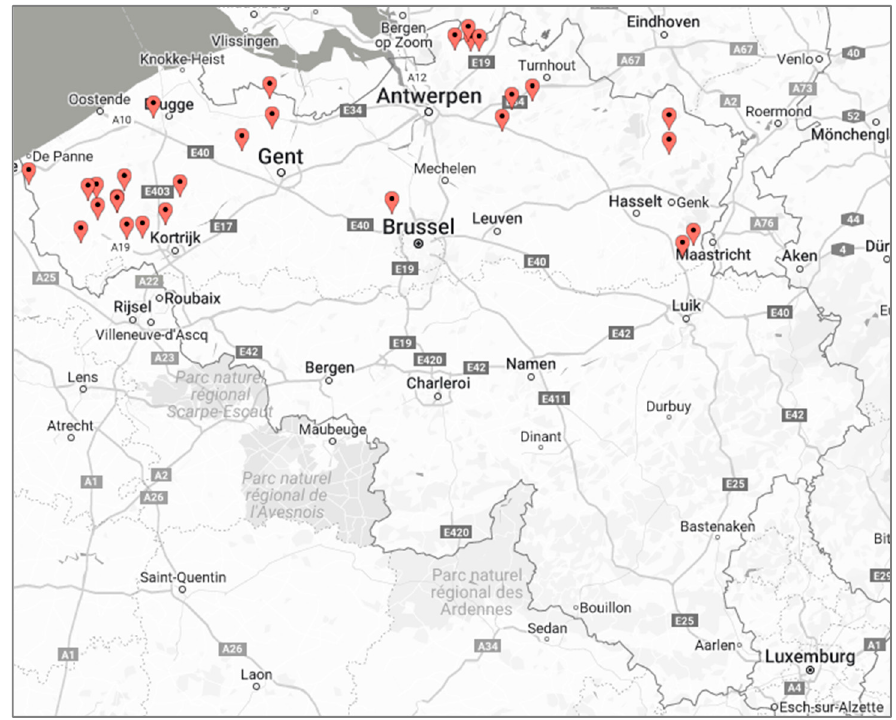
Figure 1. Map of Belgium with the geographical distribution of the farms.